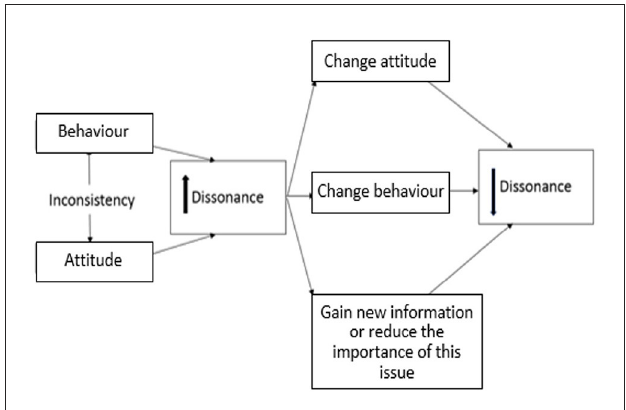
FIGURE1 The underlying mechanisms of cognitive dissonance. When an individual’s behaviour is inconsistent with his attitude, the tension of cognitive dissonance will increase unless the individual changes his/her attitude or behaviour. Alternatively, the individual may try to gain new information or reduce the importance of this